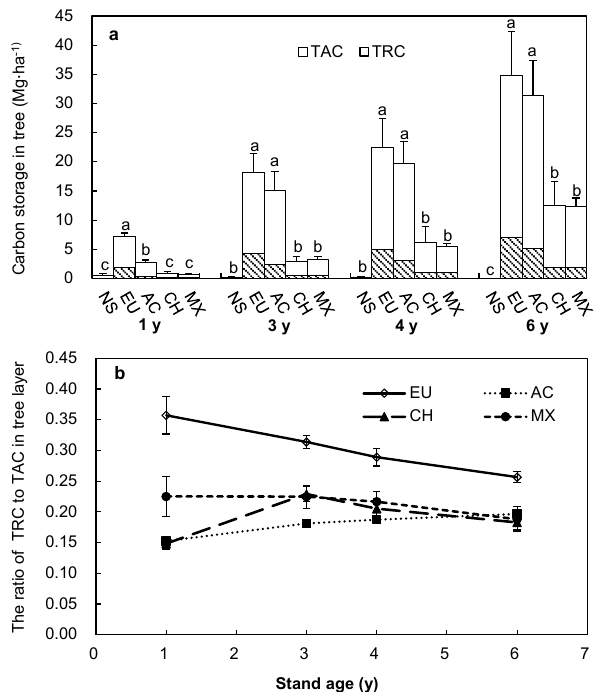
Figure 1. ( a ) Carbon storage in the tree layer along a reforestation chronosequence (1 y; 3 y; 4 y; 6 y) among plantation types; ( b ) The ratio of tree root carbon (TRC) to tree aboveground carbon (TAC) in the tree layer along a reforestation chronosequence (1 y; 3 y; 4 y; 6 y) among plantation types. Notes: naturally recovered shrubland (NS), Eucalyptus urophylla monoculture (EU), Acacia crassicarpa monoculture (AC), Castanopsis hystrix monoculture (CH) and mixed plantation of 10 species (MX). Values are the means + SE, n = 3. Repeated measure ANOVAs were used for tree total carbon storage. One-way ANOVAs were used for plantation types at a given year. Different lowercase letters indicated significant differences among plantations at the p = 0.05